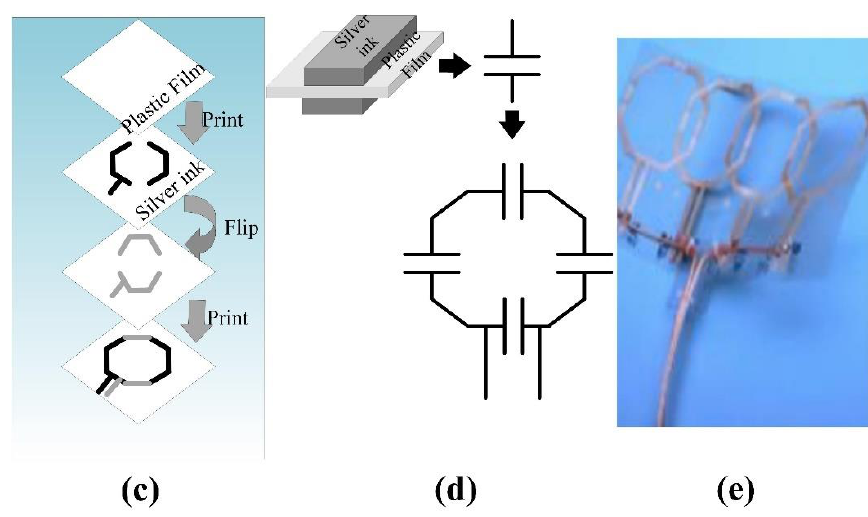
Figure 16. The wearable MRI sensor. ( a ) The 128-channel torso array coils and corresponding imaging results. Adapted with permission from ref. [117]. Copyright 2008 Wiley-Liss. ( b ) Lightness and softness coils and corresponding imaging results. Adapted with permission from ref. [120]. Copyright 2015 John Wiley & Sons. ( c ) Coil printing process flow. ( d ) Schematic of a printed coil. ( e ) Photograph of a printed coil.